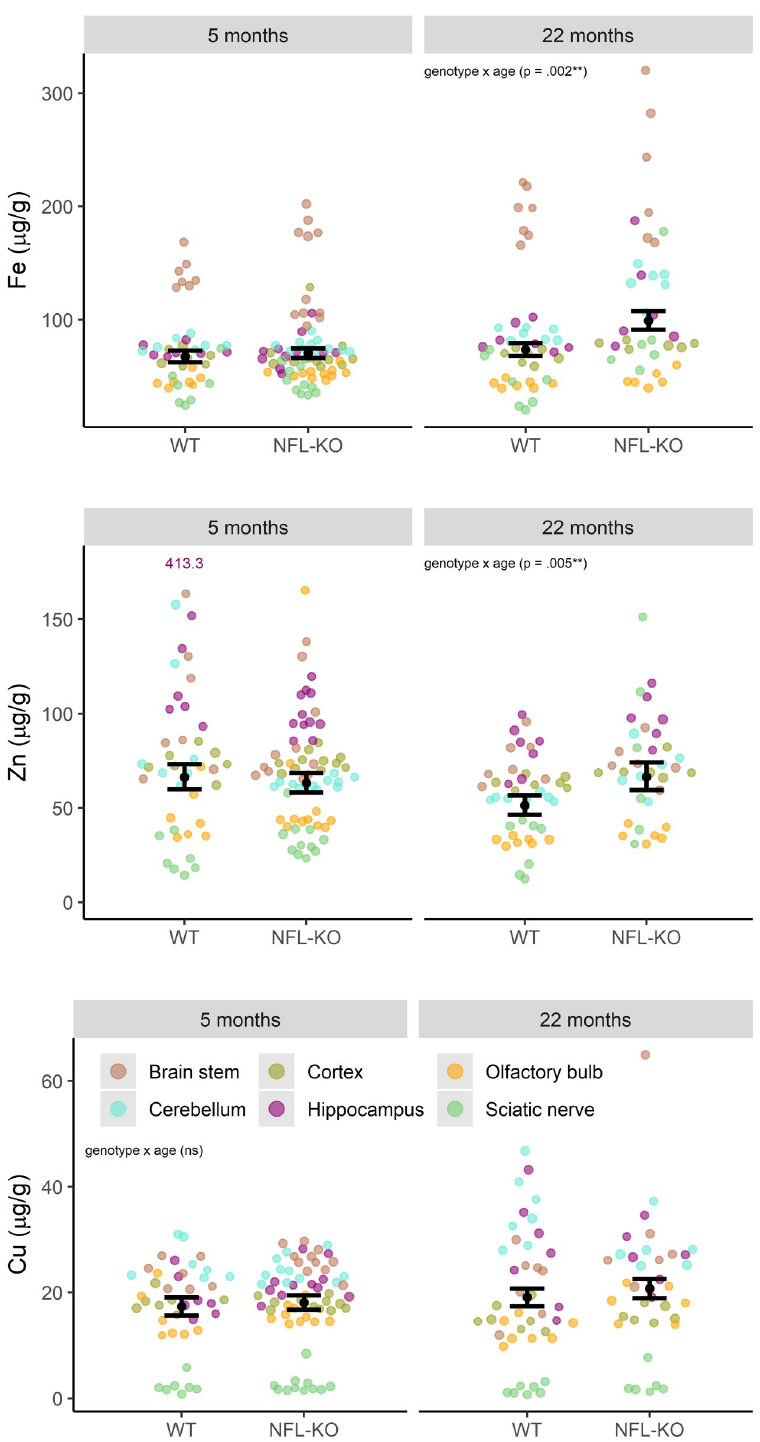
Fig 1. Metal composition at different ages. Fe, Zn, and Cu in sampled brain regions at 5mo and 22mo, for WT and NFL-KO mice. Error-bars show estimated marginal means (over all regions) and 95% CI, showing the strength and direction of these patterns of metal accumulation. There were significant genotype x age interactions for Zn and Fe (Zn: F (1, 27) = 9, p = .005; Fe: F (1, 27) = 11, p = .002).